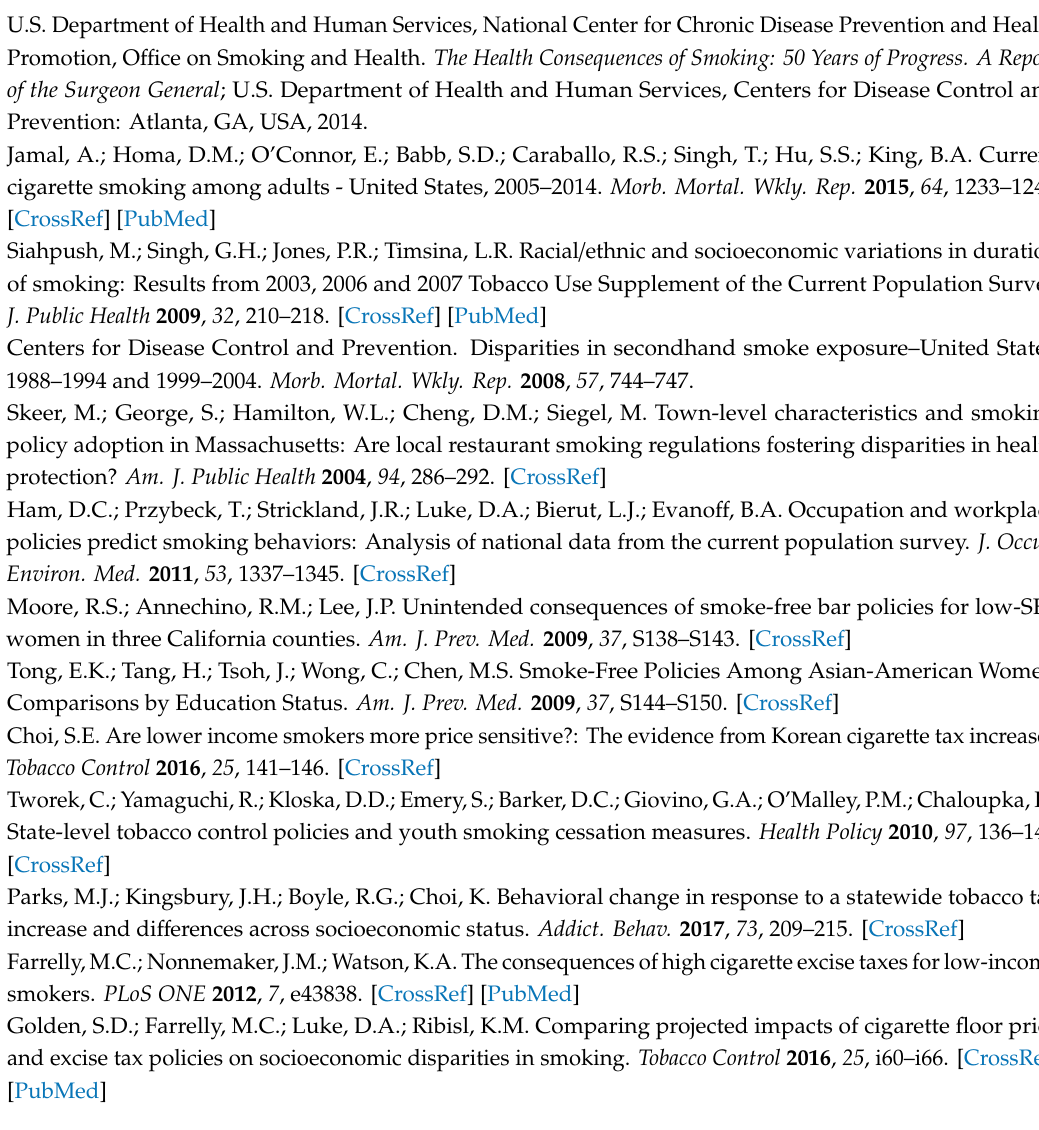
Table S1: results of sensitivity analyses for survey year and imputed income for multivariable logistic regression models with interaction terms using data from 1985–2015 supplements to the U.S. Census Current Population Survey with imputed income and defining poverty as 138% of the poverty line unless otherwise